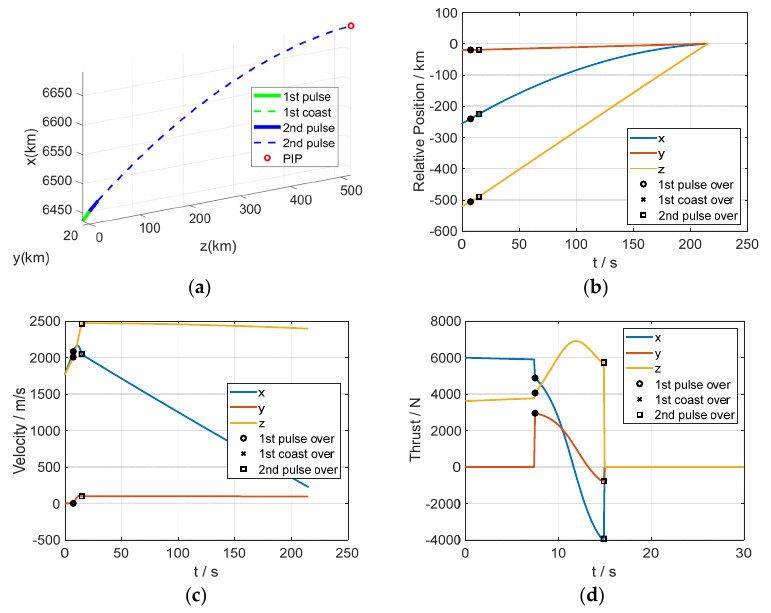
Figure 4. Curves of the state and control variables of the interceptor in scenario 2: ( a ) trajectory, ( b ) relative position, ( c ) velocity, and ( d ) thrust.